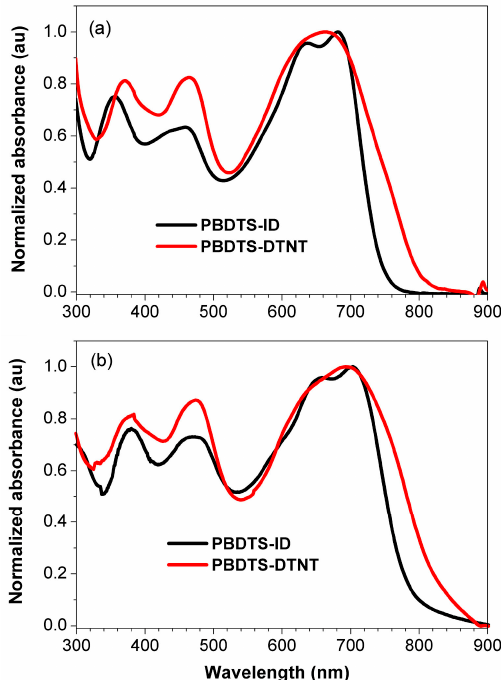
Figure 2. Normalized UV-visible absorption spectra of the polymers in chloroform solution ( a ) and thin solid films ( b ).